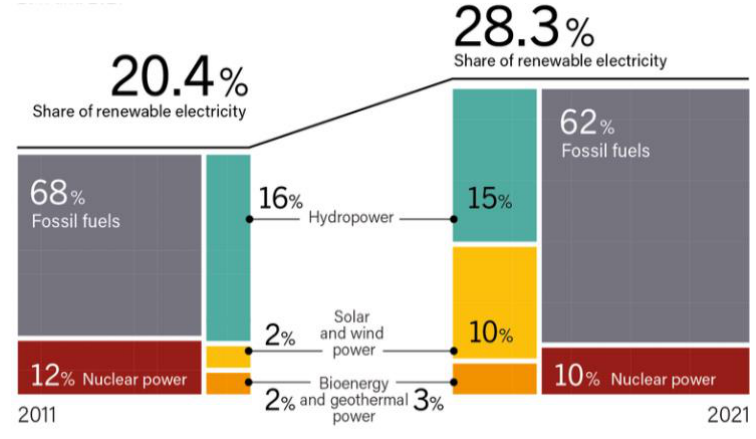
Figure 2. Share of renewable electricity in 2011 and 2021 [29].